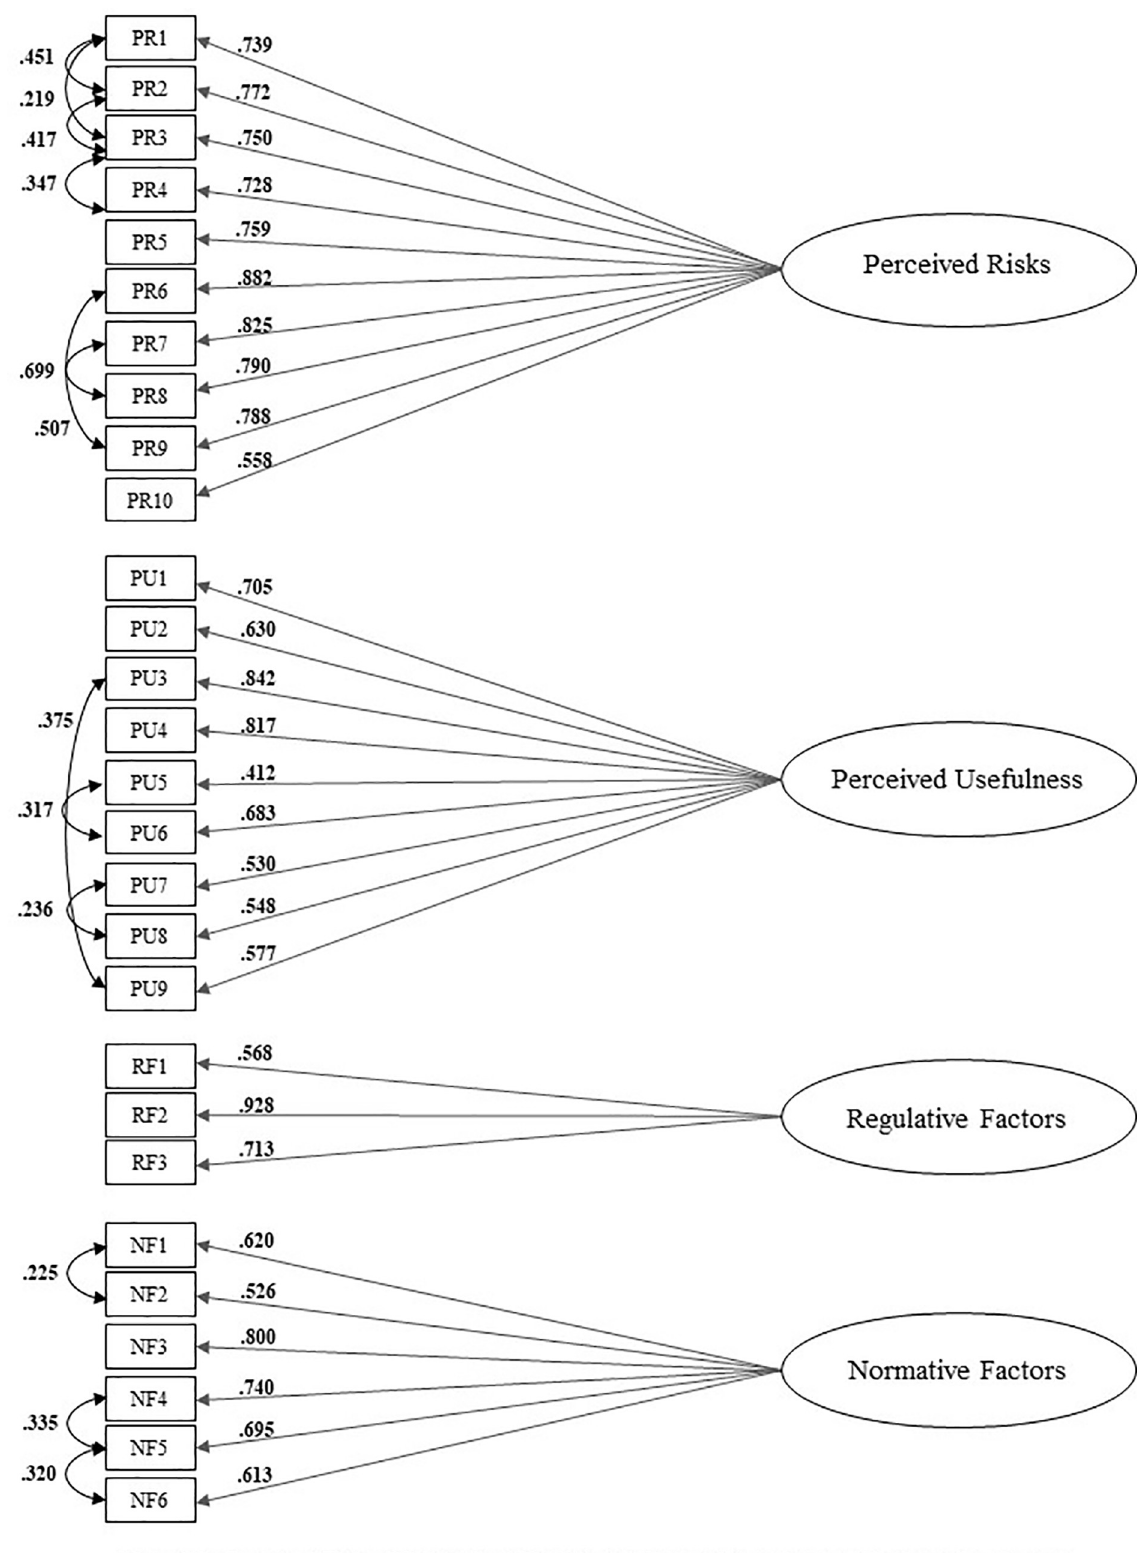
Fig 2. Model of ‘Digital Innovation Adoption in Hospitals’ (DIAH) factors at confirmatory factor analysis. https://doi.org/10.1371/journal.pone.0262003.g002 PLOS ONE | https://doi.org/10.1371/journal.pone.0262003 December30,